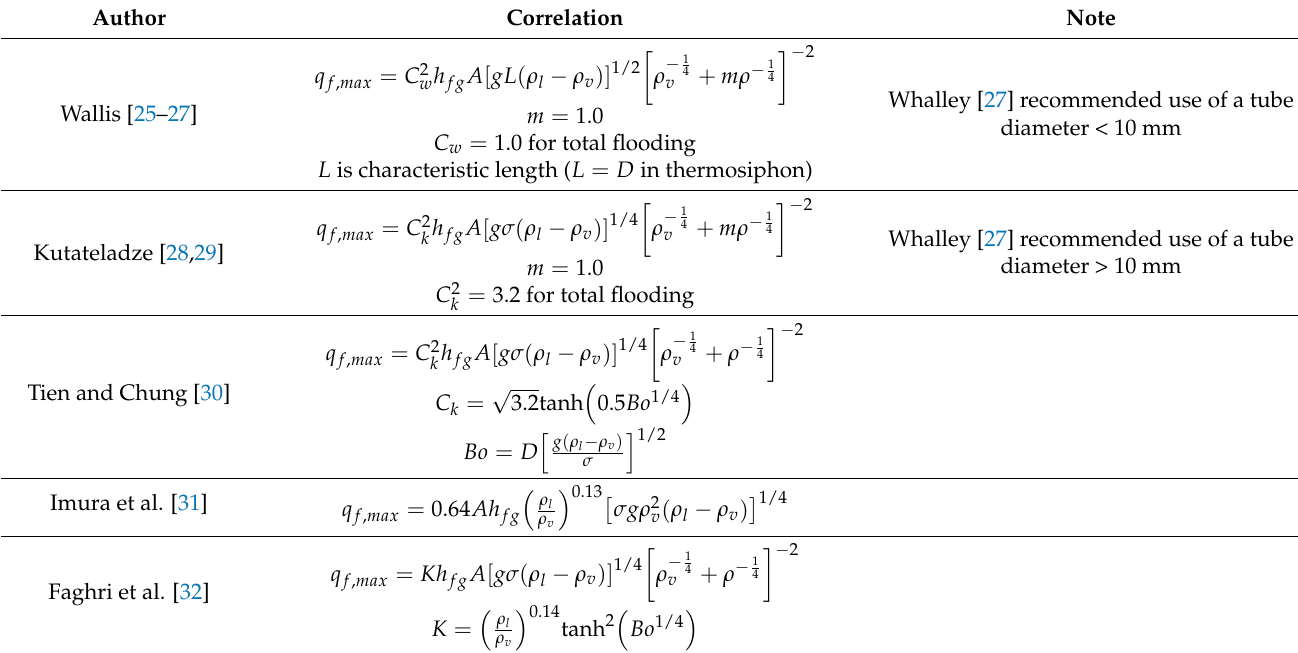
Table 3. Flooding limit correlations for a gravity-aided